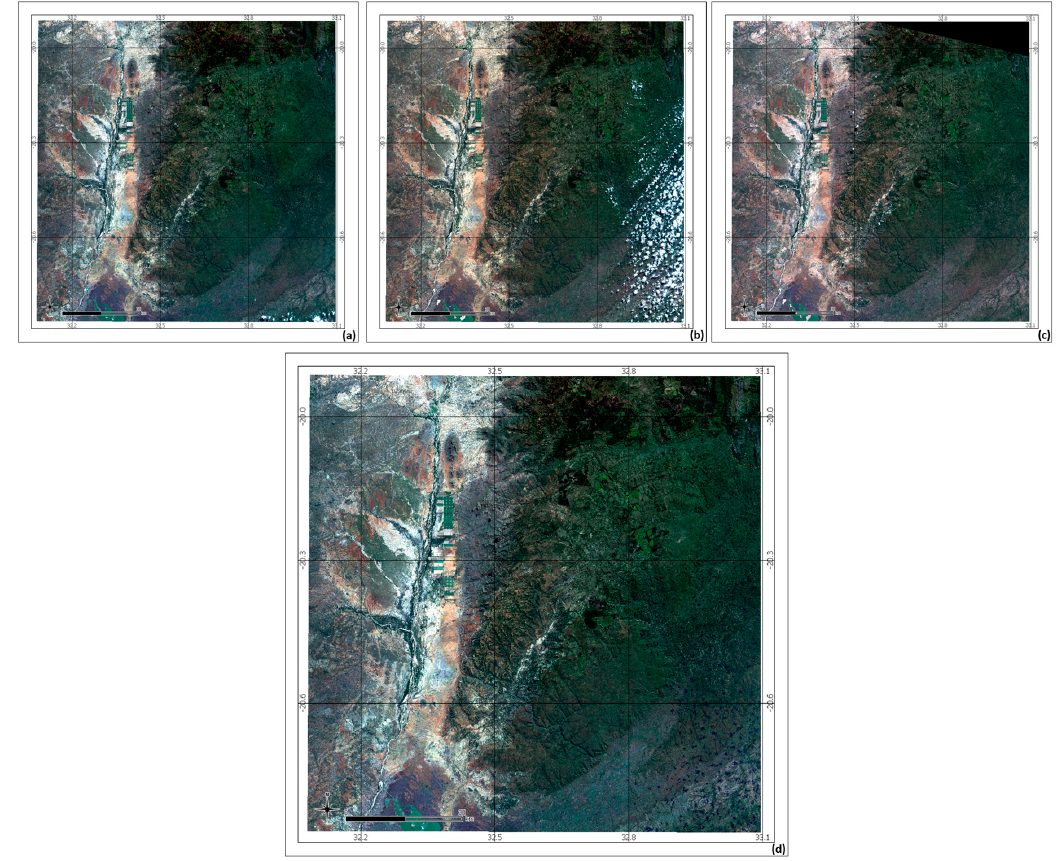
Figure 2. The figure shows the output of the darkest pixel method, it selects the lowest Top Of Atmosphere (TOA) reflectance value for each of the 10-meter bands (visible and Near Infra-Red) taking into account three months of data. ( a ) S2A image acquired on 04/05/2016; ( b ) S2A image acquired on 14/05/2016; ( c ) S2A image acquired on 24/05/2016; ( d ) 2nd Quarter 2016 composite based on darkest pixel selection, black spots are cloud shadows as consequence of darkest pixel selection. © Contains modified Copernicus Sentinel data (2016)/Processed by the European Space Agency (ESA).